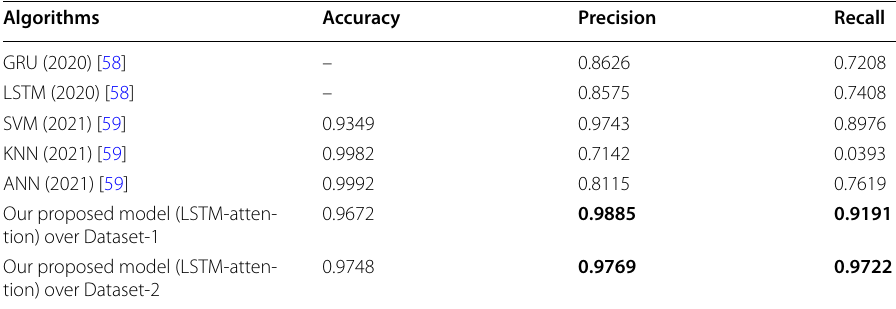
Table 5 The accuracy, recall and precision metrics